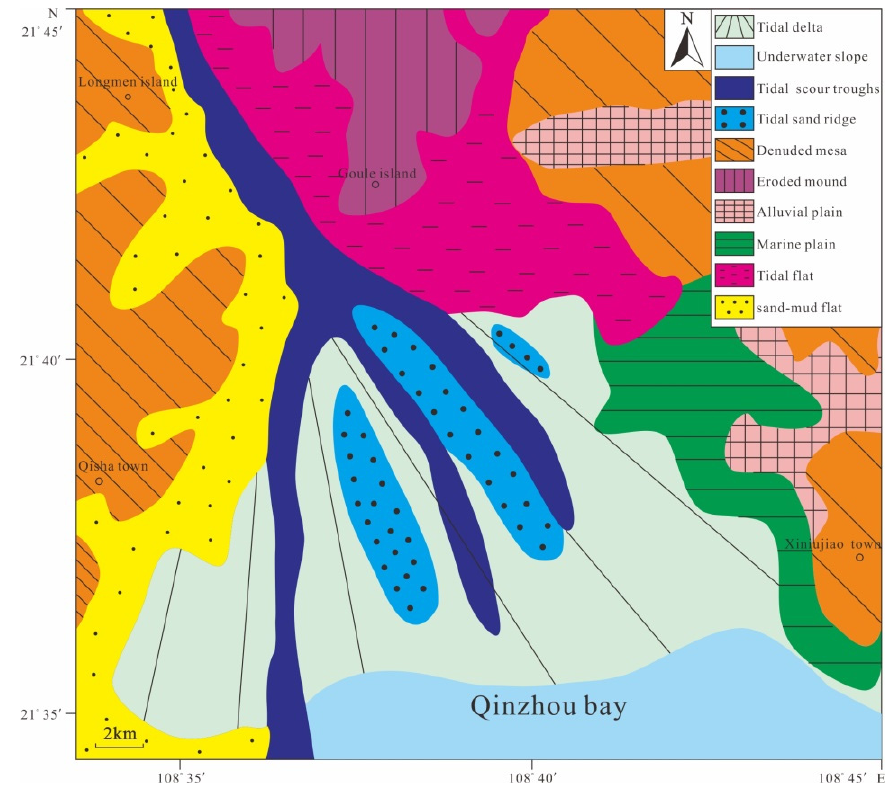
Figure 5. Coastal zone and submarine geomorphology in the research area [31].